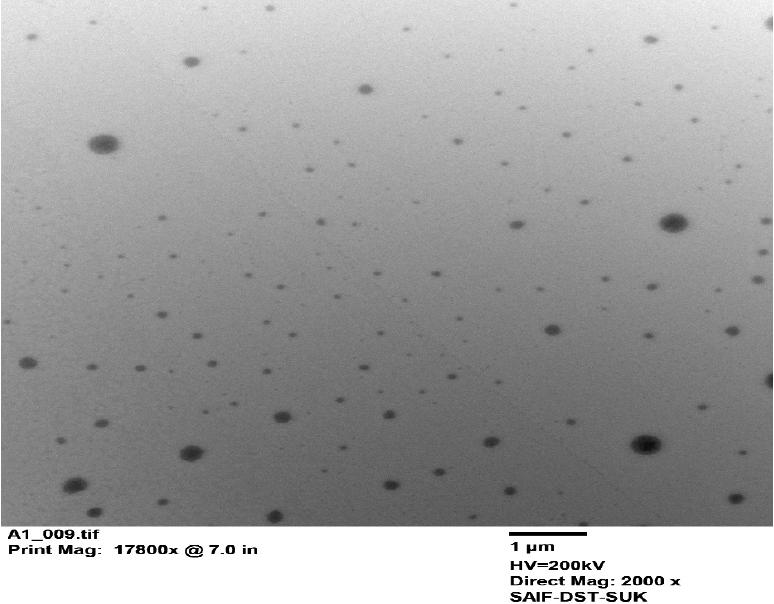
Figure 5. TEM micrograph of optimized PRX NS formulation (NS9).